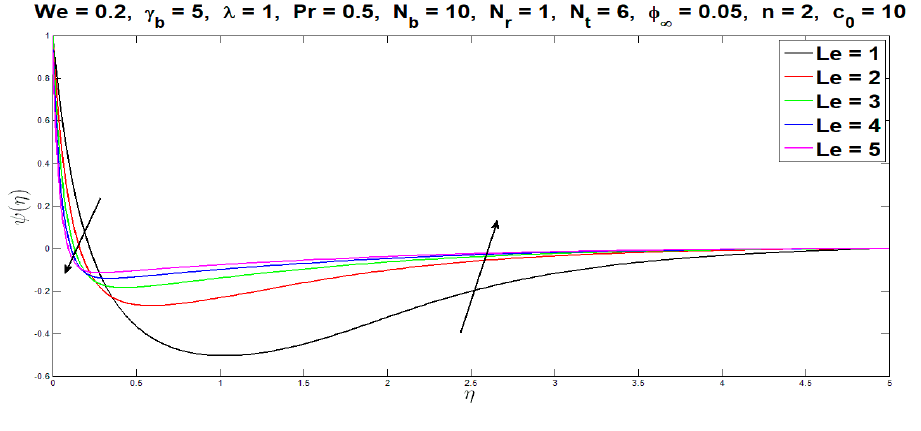
Figure 6. ( a ) Influence of L e over ψ . ( b ) Influence of γ b over 1